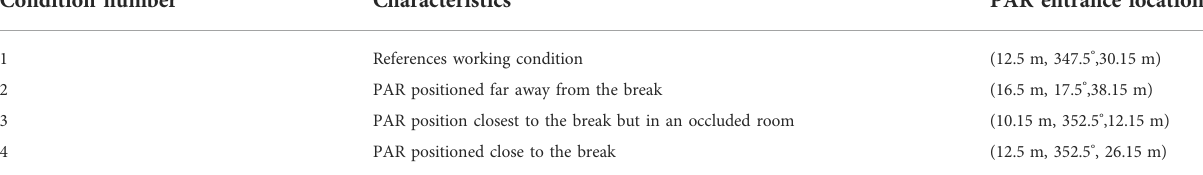
TABLE 3 Simulated working conditions for the PAR position